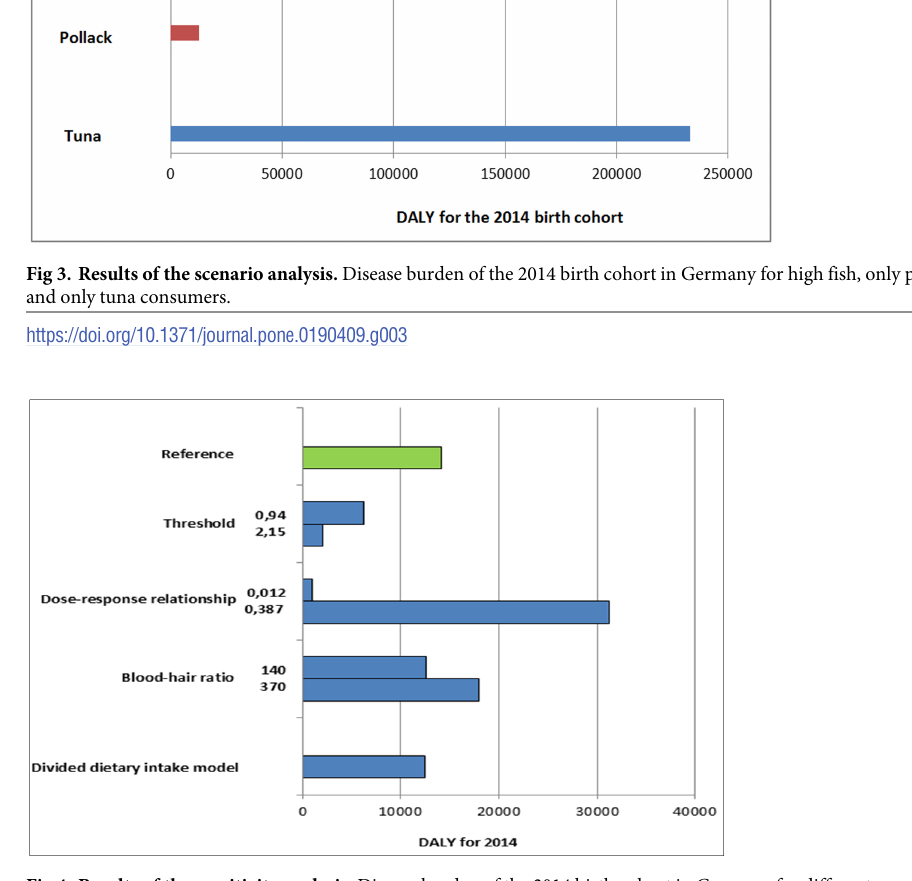
Fig 4. Results of the sensitivity analysis. Disease burden of the 2014 birth cohort in Germany for different uncertainty parameters.